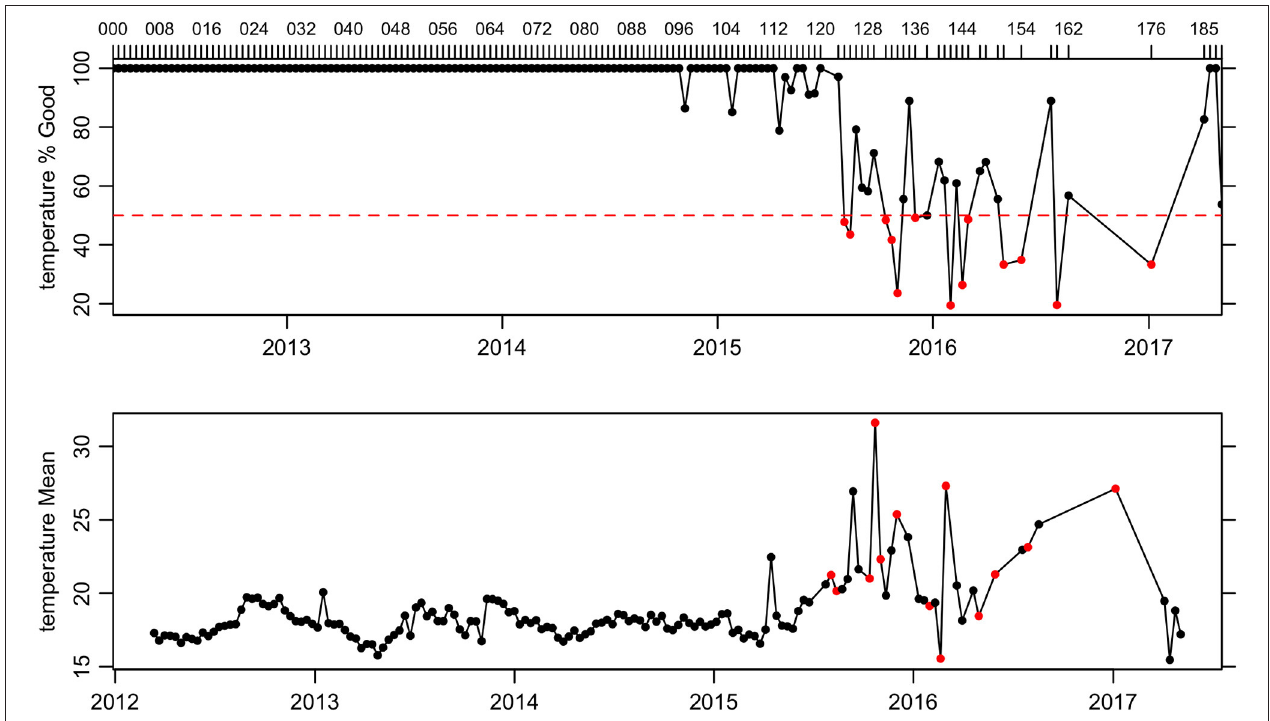
FIGURE 6 | Quality Control plot for Argo float 1901584 near the Bahamas. The top panel shows the percent of data that are likely to be trustworthy, being described with QC flag codes 1 (meaning good data), 2 (probably good), 5 (changed), or 8 (estimated). Cycles are indicated with ticks at the top margin of this panel. The bottom panel shows the depth-averaged value of the parameter in question (temperature, in this example) regardless of the flag value, with red dots indicating cycles in which more than half the data are flagged as bad.